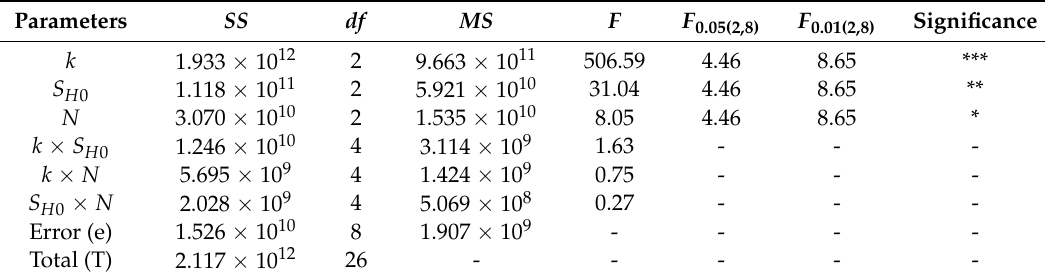
Table 6. Analysis of variance of Q cv .